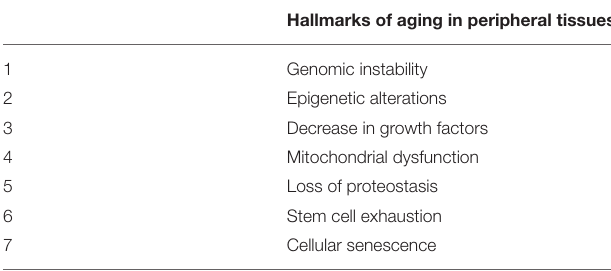
TABLE 1 | Some hallmarks of aging in peripheral tissues that are also present in brain tissue.